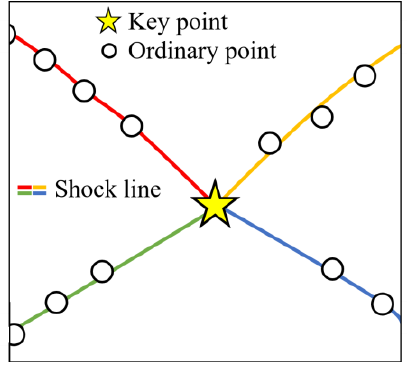
Figure 4. Fitting shock lines.